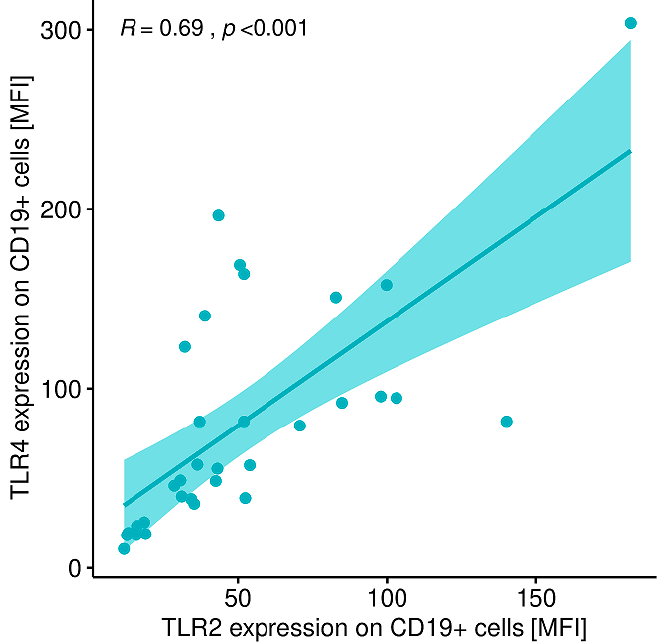
Figure 14. Correlation between the expression level of TLR-2 on CD19+ B lymphocytes (MFI) and the expression level of TLR-4 on CD19+ B lymphocytes (MFI) in patients with GD after obtaining euthyroidism. MFI, mean fluorescence intensity.